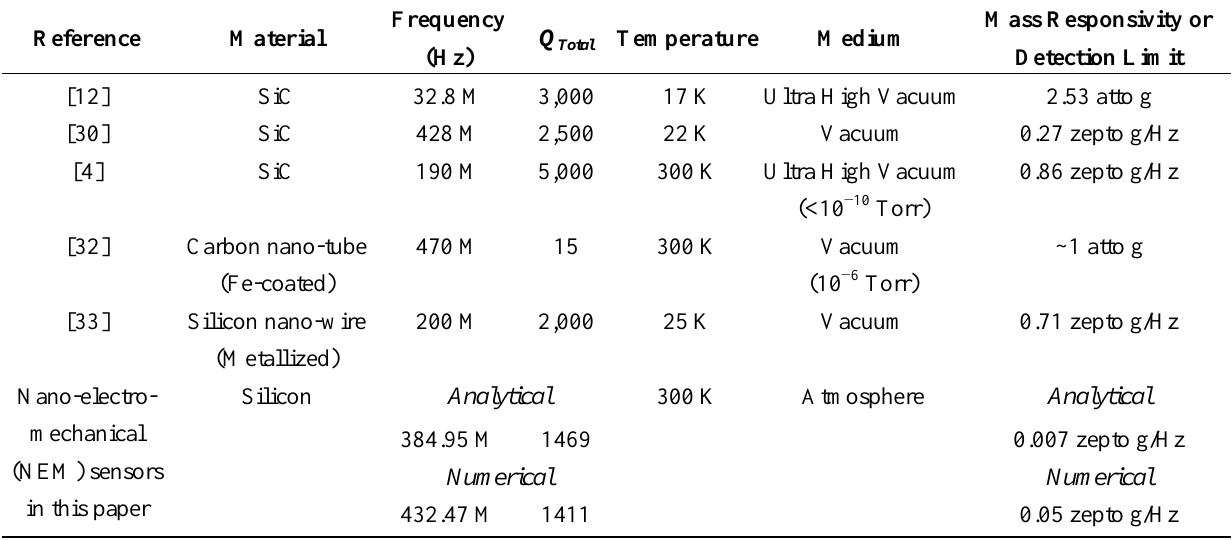
Table 4. Comparison of the in-plane resonant nano-electro-mechanical (IP R-NEM) sensor and a few recent mass detection based NEM